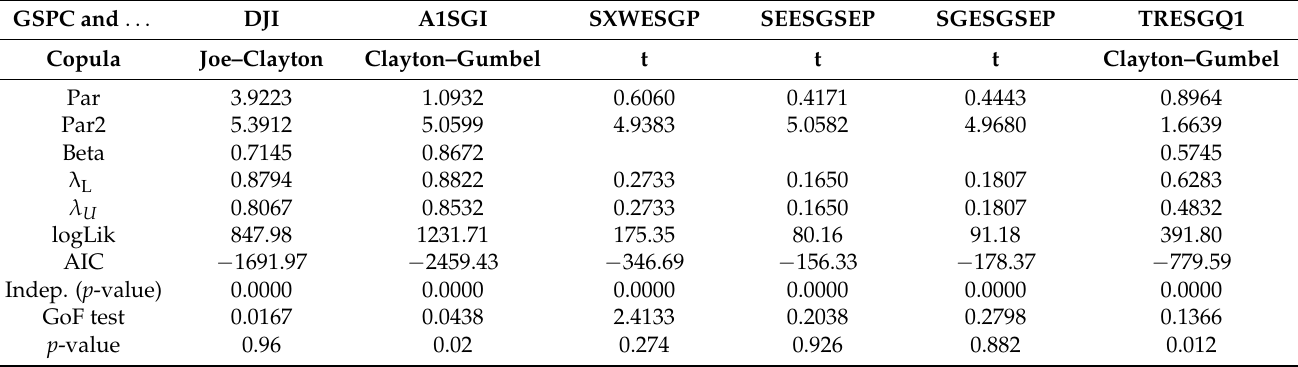
Table 11. Dependence structure for the GSPC and ESG indices, 4 January 2017–31 December 2019.